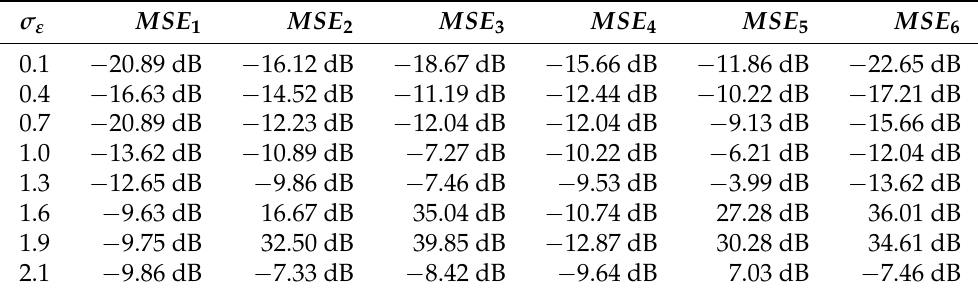
Table 1. Mean squared errors (MSEs) between IF estimations based on extracted and original components, for signal from Example 1 with P = 6 components. MSE p , p = 1,2, . . . ,6 corresponds to the p th component. The results are presented for various values of the standard deviation of the noise, σ ε . The results are averaged based on 10 random realizations of signals with random phases and noise, for each considered value of σ ε .